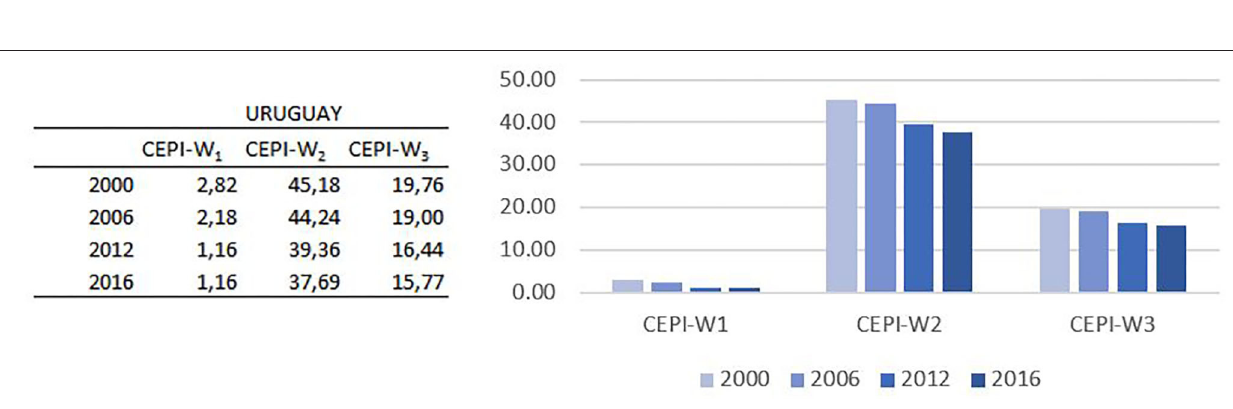
Frontiers in Sustainable Cities |